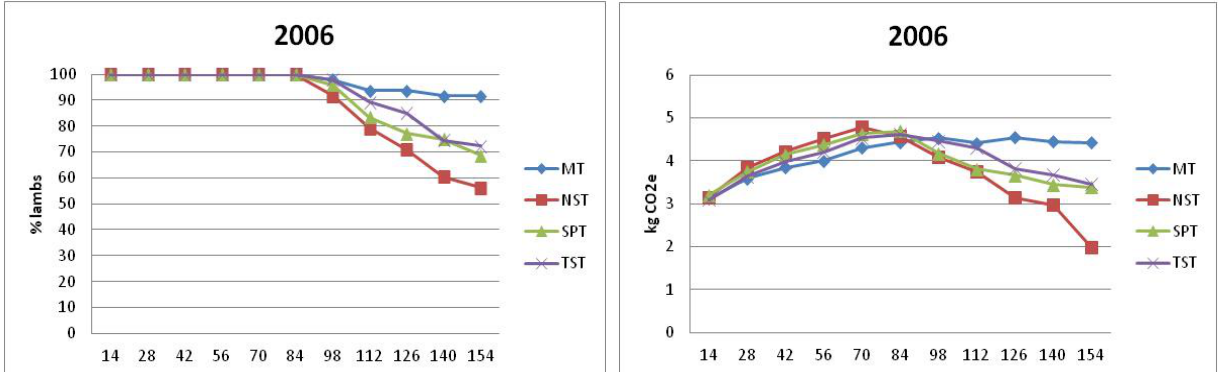
Figure 2. Pairs of plots for each of the years 2006 to 2010 showing for the four treatments (on left) the % of lambs remaining in the experiment over the 154 days ( i.e . those not yet reached the selected target weight of 38 kg) and (on right) the estimated greenhouse gas e per lamb) for each successive 14 day footprint (average kgCO 2